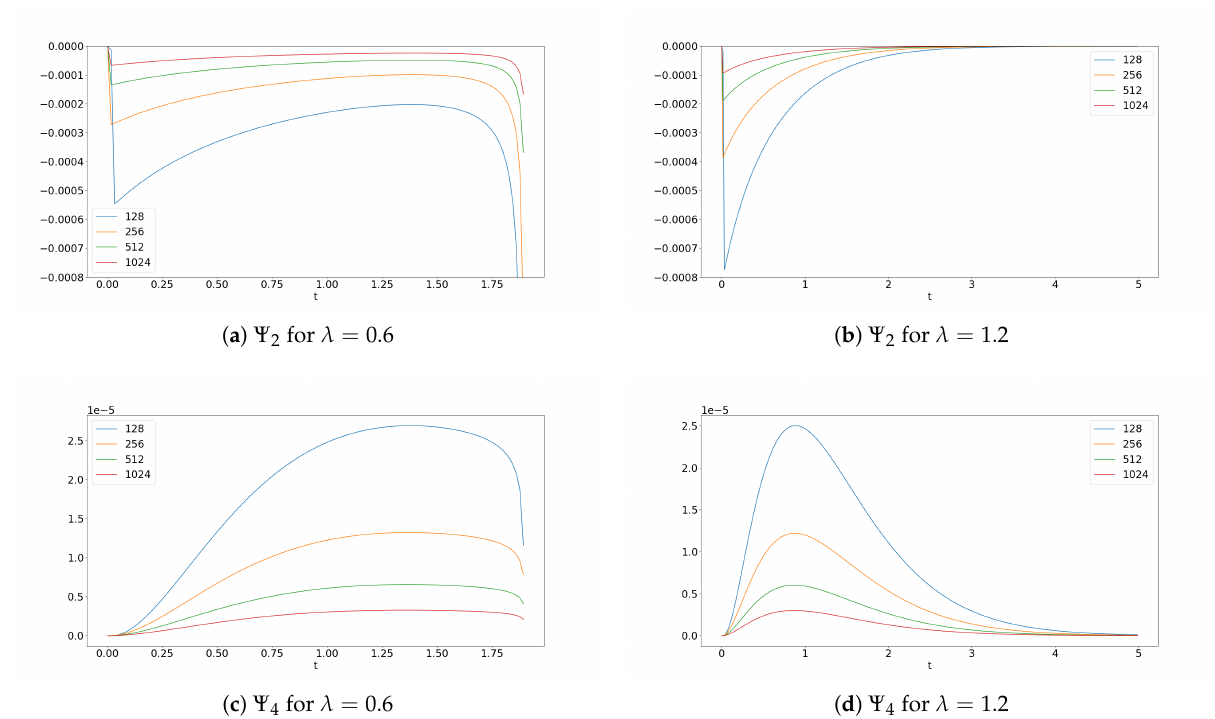
Figure 9. Plots along z = 1 of Ψ 2 and Ψ 4 as a → ∞ with λ = 0.6 and λ = 1.2. Like in the λ = 0 case this is a curvature singularity. It is much easier to see this in the λ > 0 case as the Weyl invariant I diverges to positive